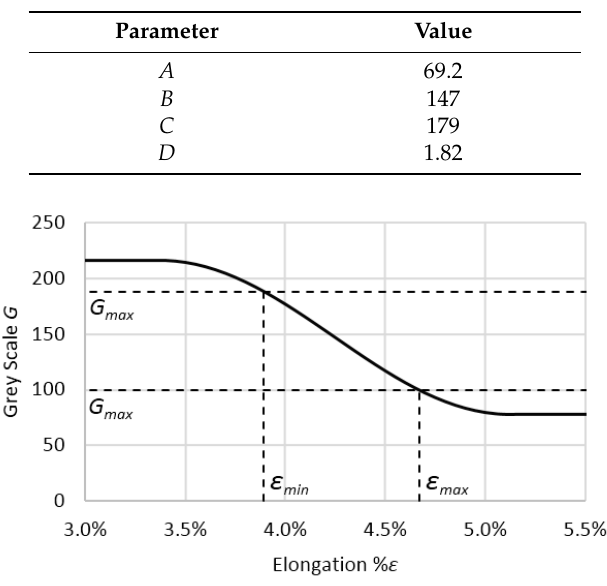
Table 2. Calibration of the grey scale to elongation ( G- ε ) curve parameters used in calculation.